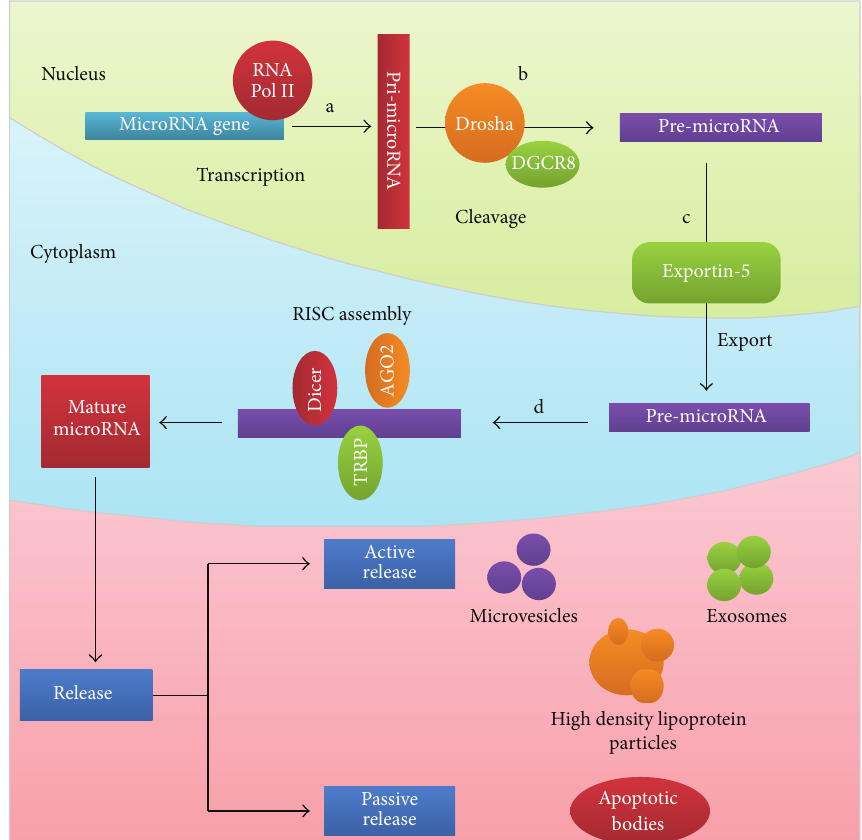
Figure 1: miRNA biogenesis mechanism. miRNA synthesis begins with RNA polymerase II action on protein coding genes. (a) Through the transformation phenomenon of the miRNAs genes, pri-miRNA is forming. (b) By the action of RNase III endonuclease (Drosha) and of the DiGeorge Syndrome Critical Region 8 (DGCR8) cofactor, the pre-miRNA is forming. (c) Through transporting protein Exportin-5, pre- miRNA is transferred from the nucleus into the cytoplasm. (d) In the cytoplasm pre-miRNA is attacked by second RNase III endonuclease (Dicer) and transactivator RNA binding protein forming mature miRNA (double-stranded) and miRNA ∗ (passenger strand). In what follows, mature miRNA induced silencing is taken in complex (RISC). RISC complex contains mature miRNA and protein Argonaute 2 (AGO) that confers increased stability of the complex. After this, miRNAs are released from the cell by two mechanisms: active release (microvesicles, exosomes, and high density lipoprotein particles) and passive release (apoptotic